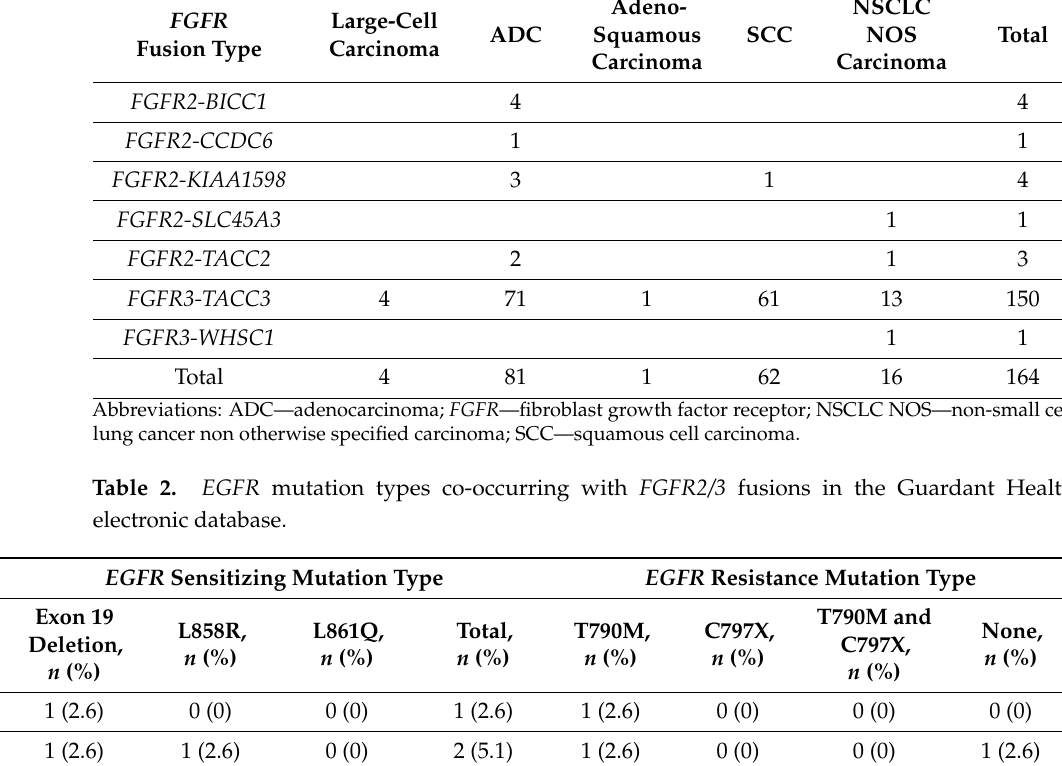
Table 1. FGFR2/3 fusion subtype prevalence and distribution across different histological non-small cell lung cancer subtypes in the Guardant Health electronic database. FGFR